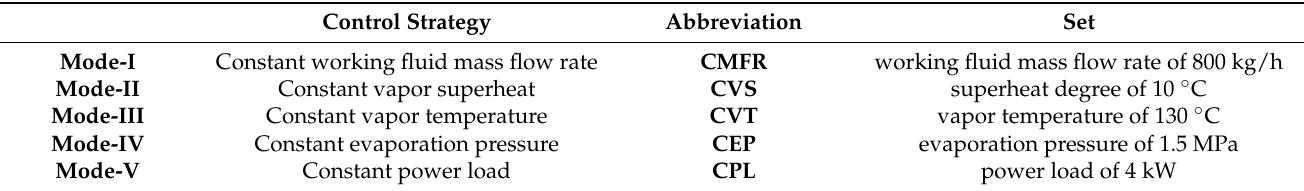
Table 6. Control strategy abbreviation and preset parameters.